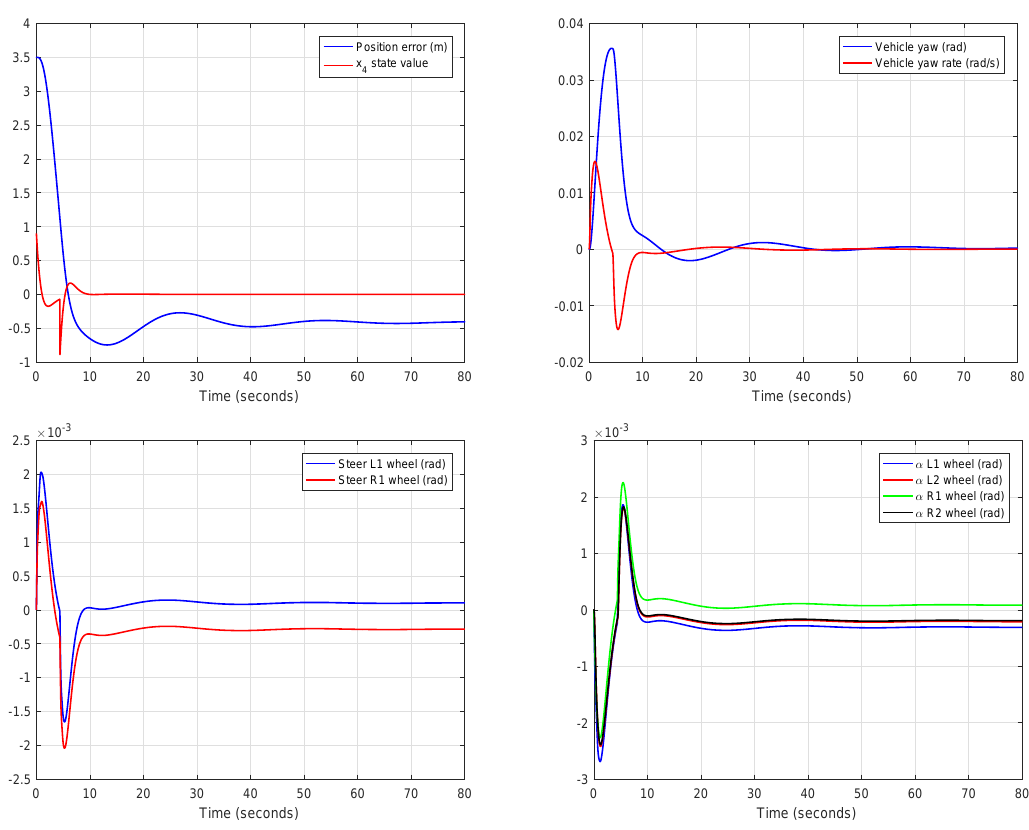
Figure 35. Detail of the experiment for the controller with variable band and optimal reset with an external disturbance in